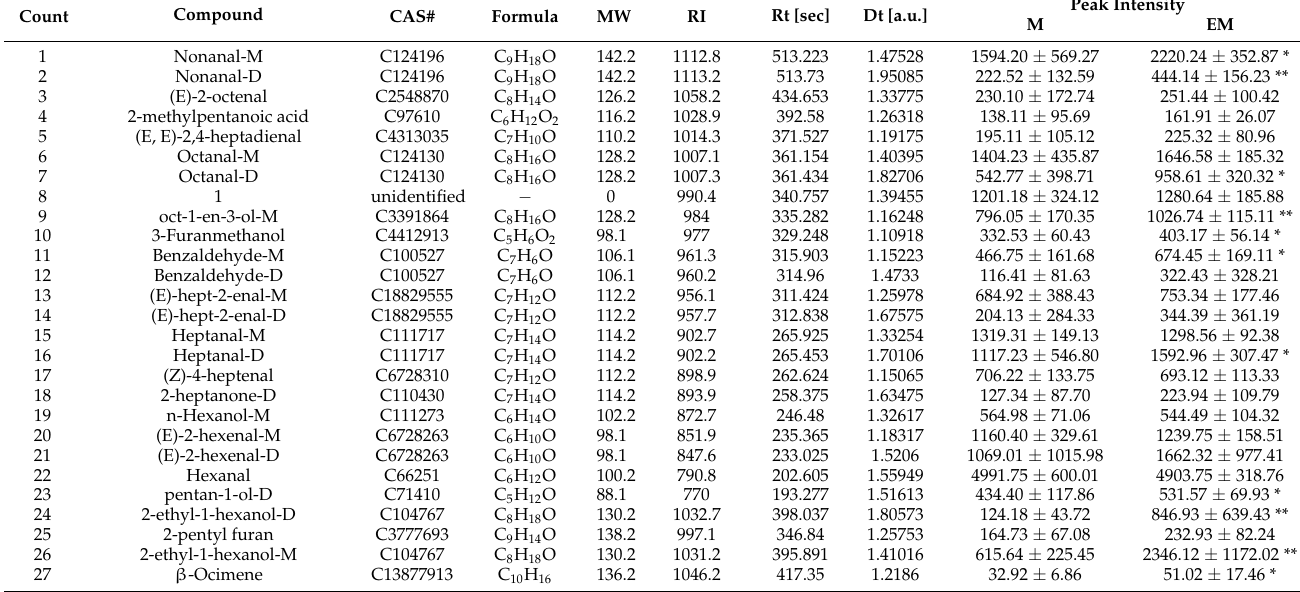
Figure 6. Principal component analysis of flavor compounds in largemouth bass muscle samples. Table 6. Qualitative results of the gas-phase ion mobility spectra of Micropterus salmoides muscles ( n =